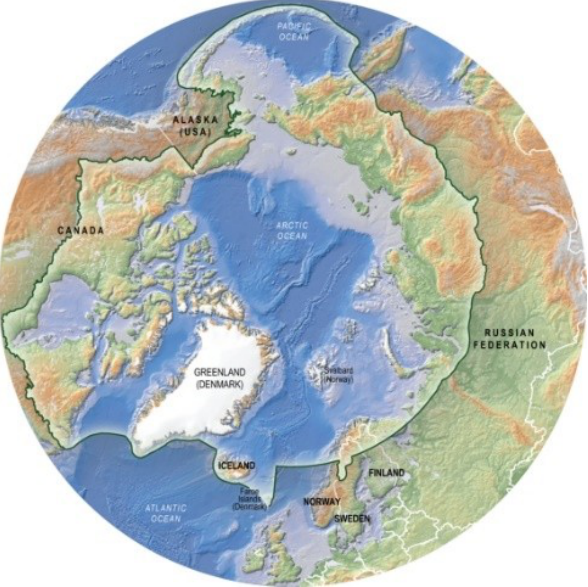
Figure 1. Area of the Conservation of Arctic Flora and Fauna (CAFF). Source: GRID-Arendal, topographic map (http://www.grida.no/resources/5304). Table 1. Structuring of studied change drivers and characteristics in published research on Arctic wetland landscapes within the CAFF boundary. Category Name Description: Current Status and Changes in . .